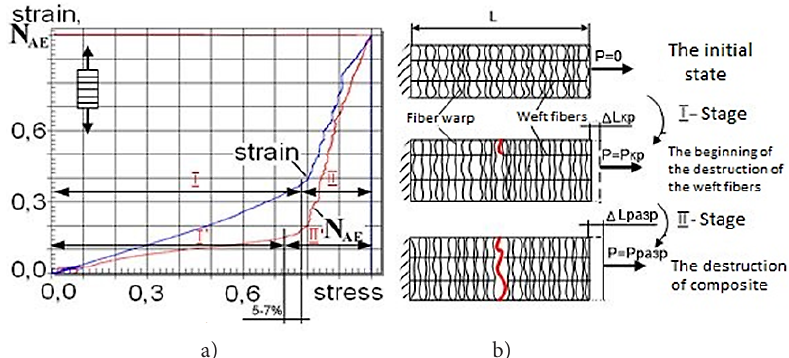
Figure 3. Schedule of changes in the total acoustic emission and deformation from stress (a) and the proposed mechanism for the destruction of the composite in the transverse arrangement of the fibres of the base relative to the tensile force (b)